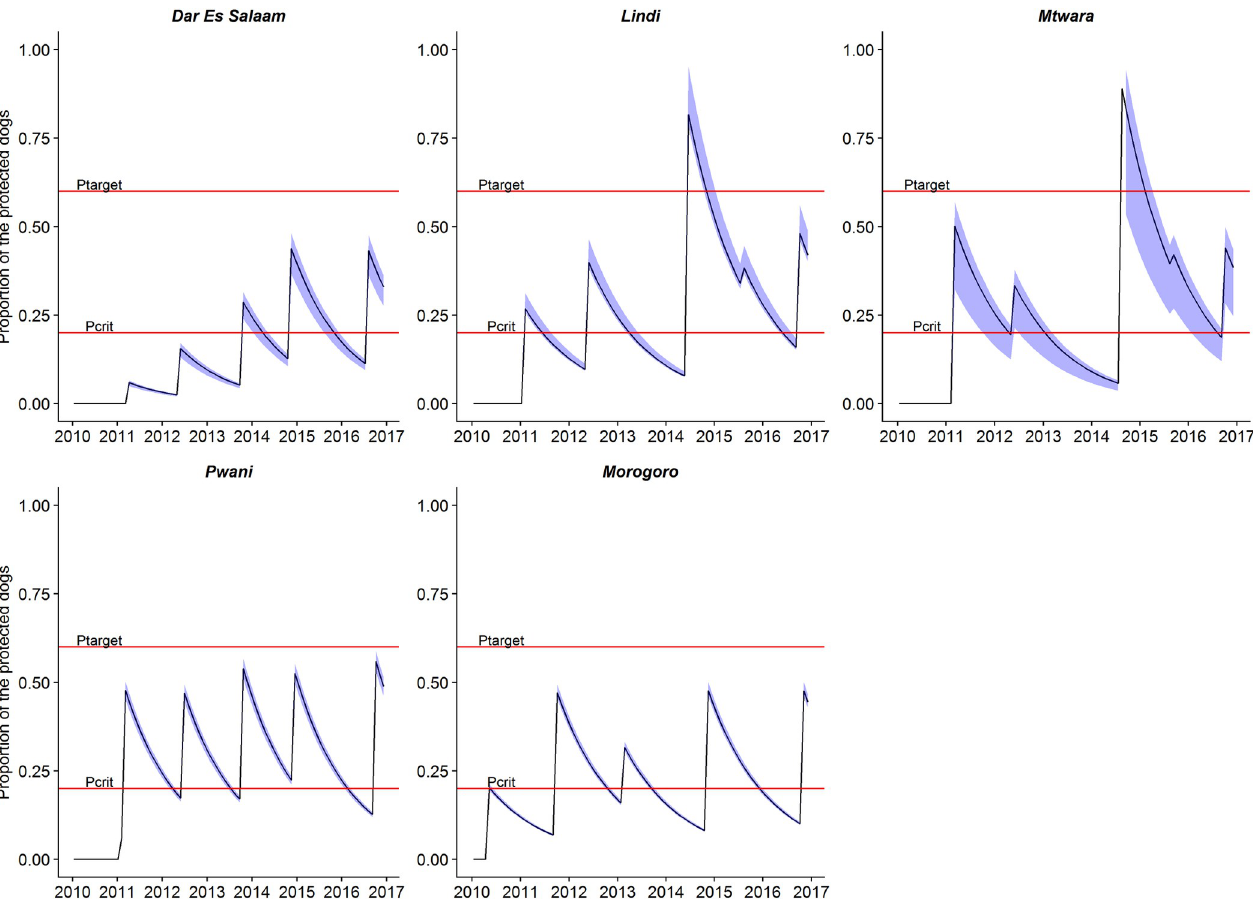
Fig 5. The campaign timeliness in each of the five regions from 2010 to 2017. The target coverage (P target ) of 70% was not achieved in all regions (upper red line), and between campaigns coverage declined due to dog population turnover. When annual campaigns achieved high coverage, coverages were sustained above the critical immunity threshold (below the red line labelled P crit ) for approximately 12 months. The time lag between campaigns (up to > 20 months), caused coverage to decline below P crit . Mean coverage across all district in the regional was calculated from the number of vaccinated dogs in each region divided by the number of estimated dogs in each